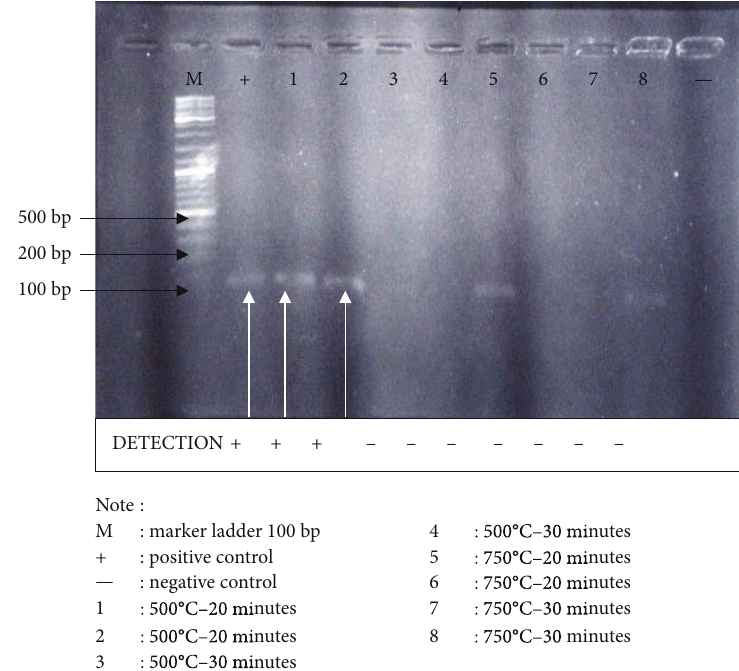
Figure 1: Visualization of FGA locus of the tooth sample PCR results using a mini